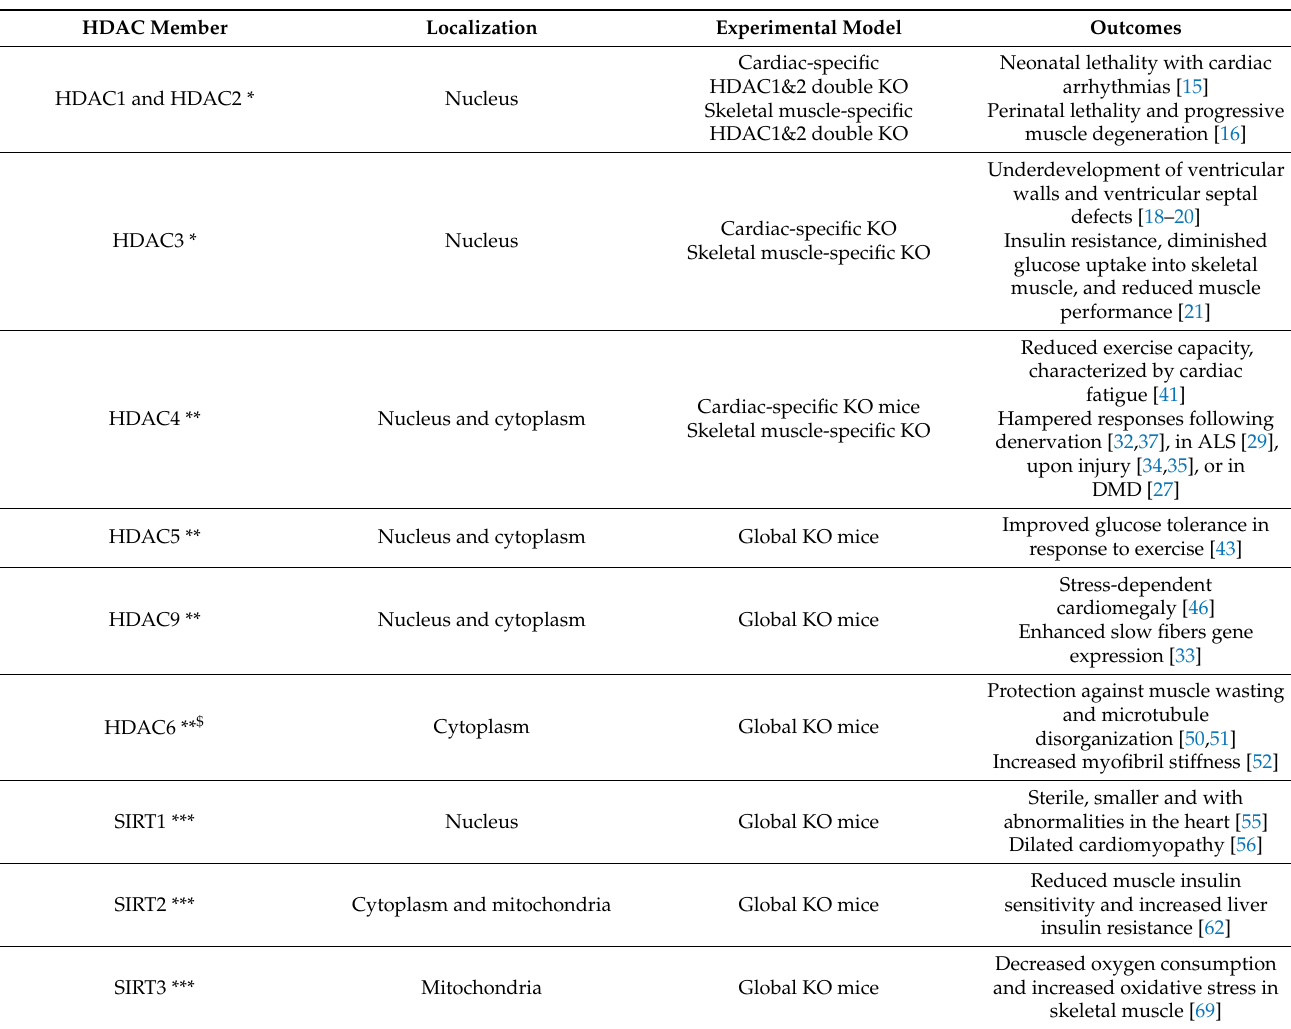
Table 1. Histone deacetylase classification, localization, and functions in striated muscles based on KO